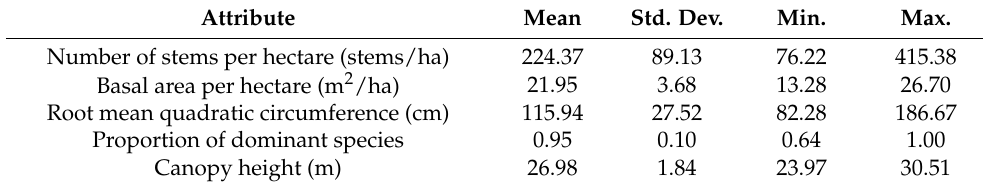
Table 2. Independent plot forest attributes ( n = 13).